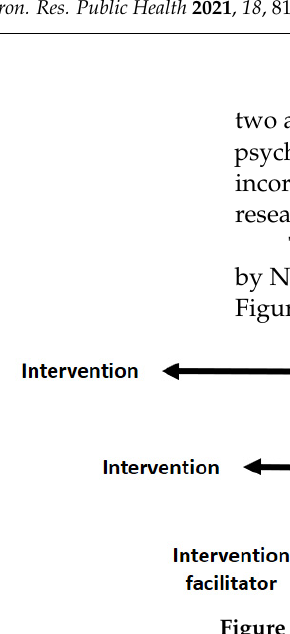
Figure 1. Three important fits in an Organizational Intervention (OI).